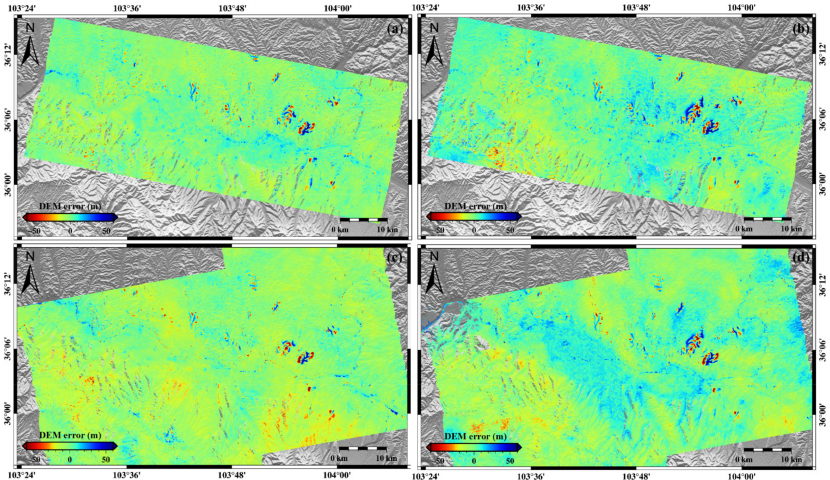
Figure 9. Estimated DEM errors of the study area at different time periods using ascending and descending Sentinel-1 SAR images: ( a ) DEM error between 8 December 2015 and 8 June 2020 estimated with descending images; ( b ) DEM errors between 20 June 2020 and 23 March 2021 estimated with descending images; ( c ) DEM error between 15 December 2015 and 16 June 2020 estimated with ascending images; and ( d ) DEM error between 2 August 2020 and 30 March 2021 estimated with ascending